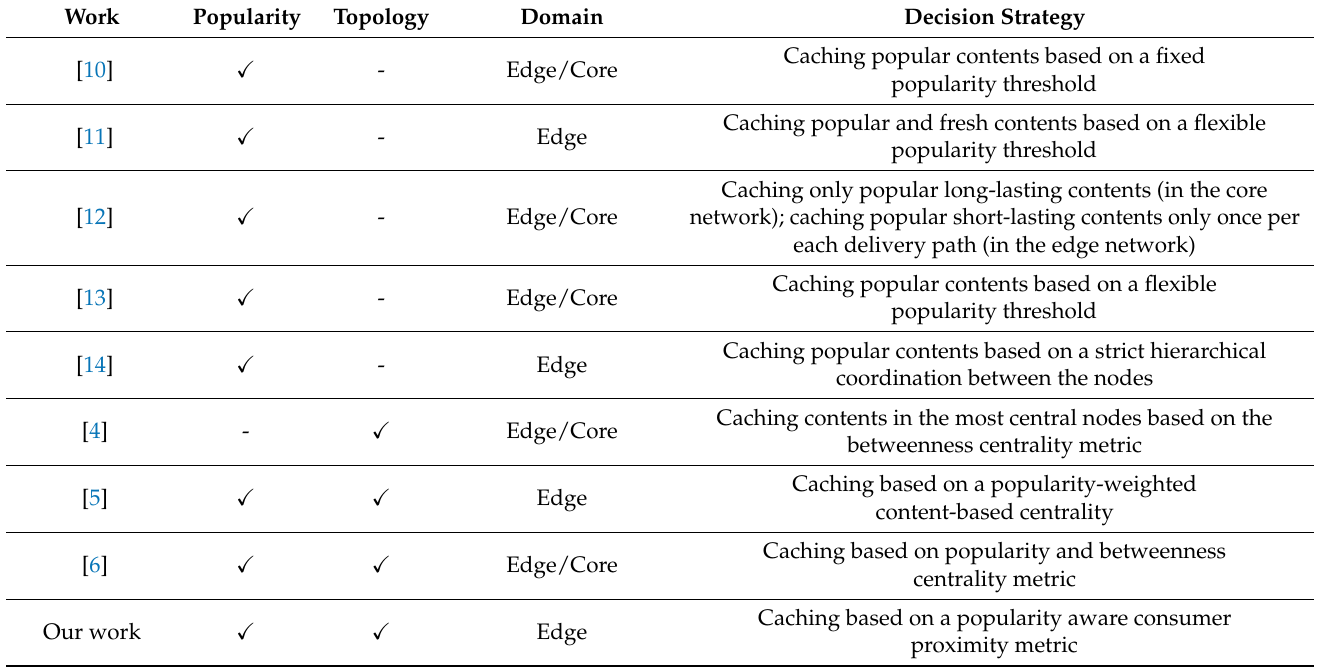
Table 1. Comparison of caching strategies based on popularity and/or topology